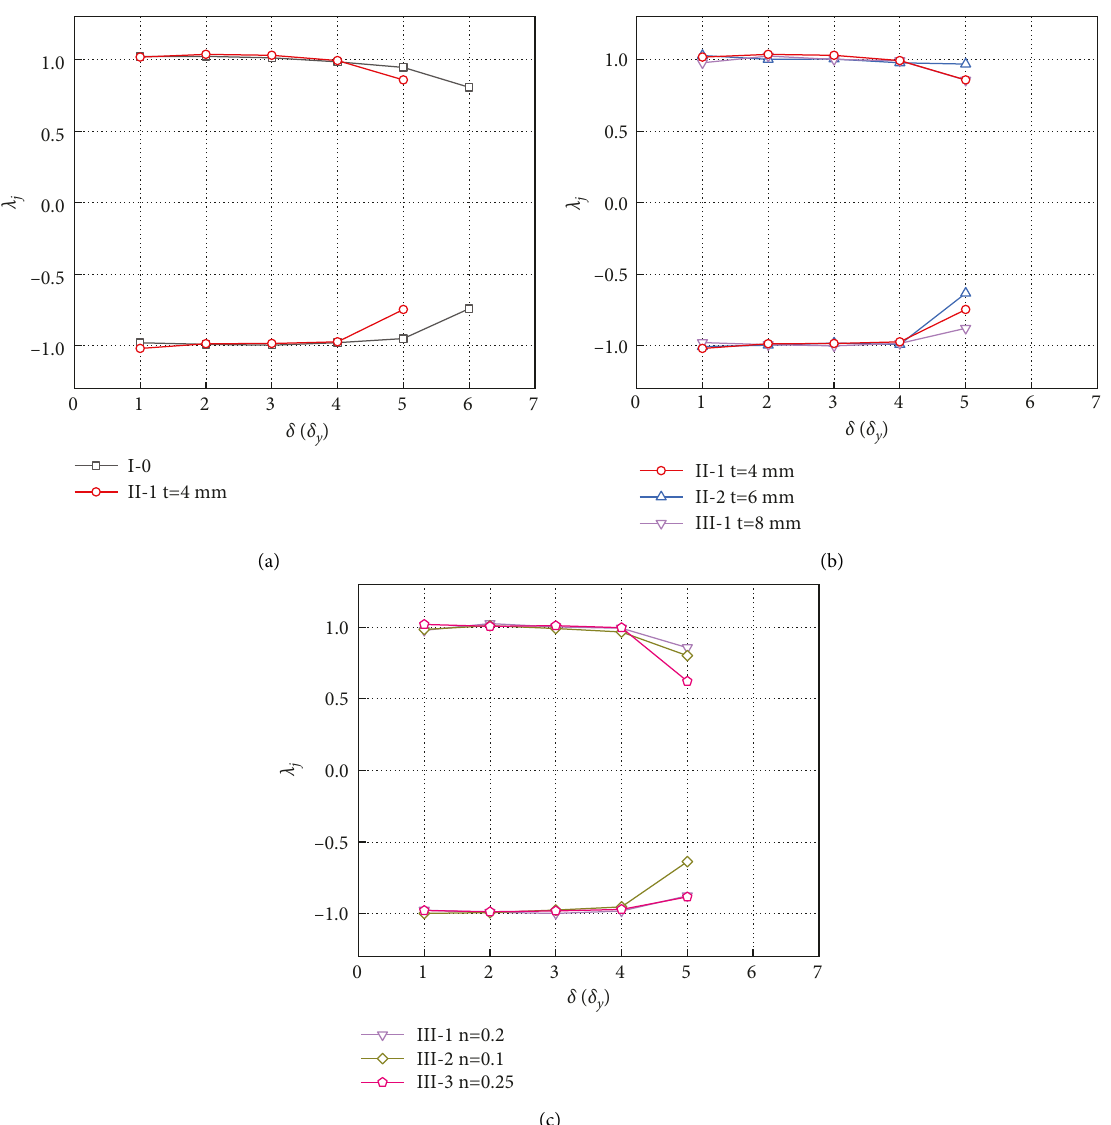
Figure 16: Strength degradation curves of specimens. (a) Impacts of energy-dissipating plates. (b) Impacts of the thickness of energy- dissipating plates. (c) Impacts of axial compression